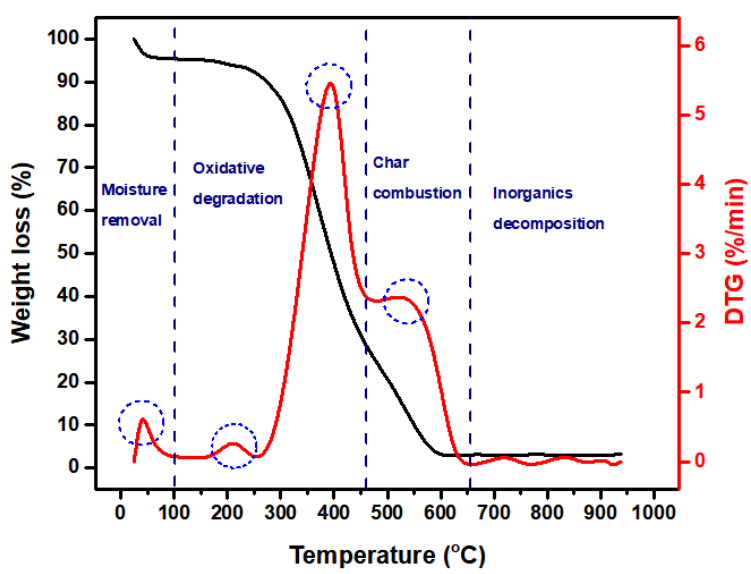
Figure 8. TG-DTG curves of thermal decomposition of olive kernel under air. Table 5. Characteristic thermal and kinetic parameters of olive kernel under oxidative conditions (air).